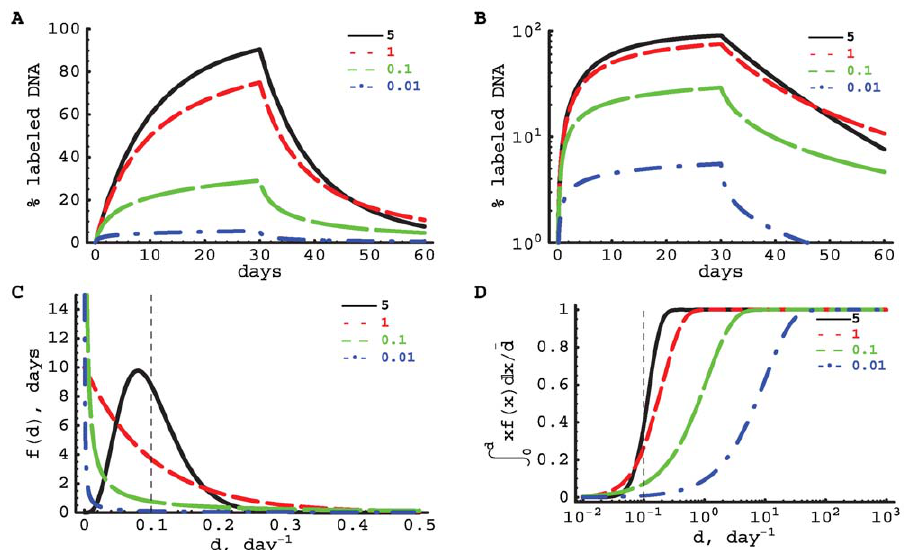
Figure 3. Model predictions for gamma-distributed turnover rates. We have plotted the changes in the fraction of labeled DNA according to the kinetic heterogeneity model with gamma-distributed turnover rates (eqn. (4)) with average turnover rate (cid:1) dd ~ 0 : 1 /day on a linear (panel A) or logarithmic (panel B) scale. Predicted changes are shown for different values of the shape parameter k . Larger values of k correspond to a more symmetric distribution (Panel C). For low values of the shape parameter k , the loss of labeled DNA after label cessation is biphasic, which is most clearly visible on a logarithmic scale for k v 1 (panel B). This characteristic of the kinetic heterogeneity model differs from the Asymptote models which have a constant per capita rate at which labeled DNA is lost. Note that for shape parameters k v 1 , the distribution of turnover rates f ( d ) becomes extremely skewed with most cells undergoing hardly any division and relatively few cells undergoing extremely many rounds of division (panel C). Panel D gives the cumulative contribution of sub-populations with a particular turnover rate d to the average rate of turnover of the population (cid:1) dd . The vertical line shows the value of the average proliferation rate (cid:1) dd . For high values of the shape parameter ( k ~ 5 ), the cell sub-populations with turnover rates that are somewhat lower or higher than (cid:1) dd give the main contribution to the average turnover rate. In contrast, for low values of k ( k ~ 0 : 01 ), the major contribution to the average turnover rate comes from sub-populations with extremely rapid turnover rates ( d & (cid:1) dd ); about 50% of the average turnover is due to a few sub-populations with turnover rates that exceed 10 per day, which is biologically